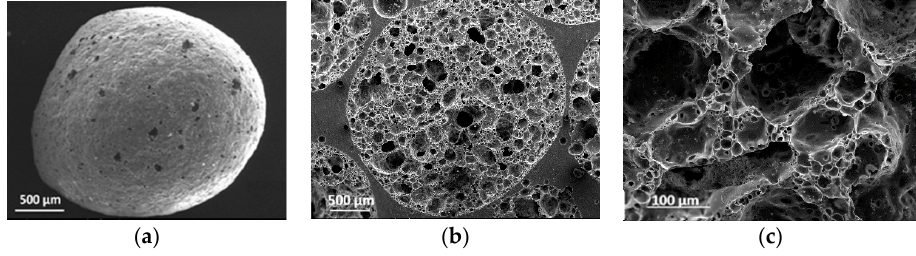
Figure 1. Scanning electron images of EG particle: ( a ) EG particle shell; ( b ) EG cross-section; and ( c ) pore wall.